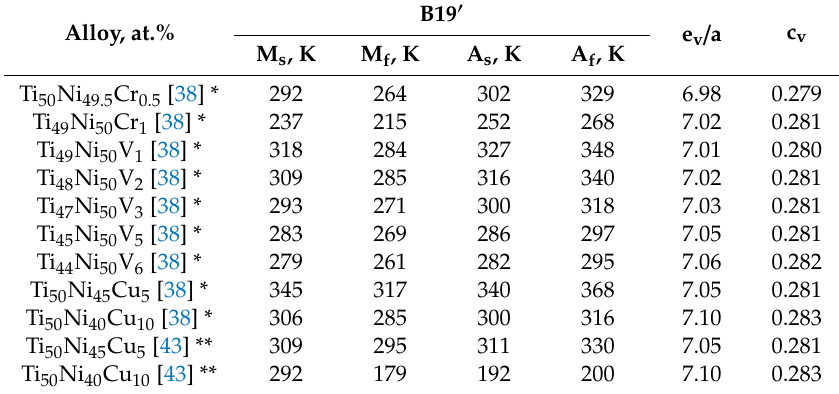
Table 5. Chemical composition, temperatures of TMTs B2 ↔ B19 (cid:48) , the number of valence electrons per atom e v / a and their concentration c v . B19 Alloy, at.%